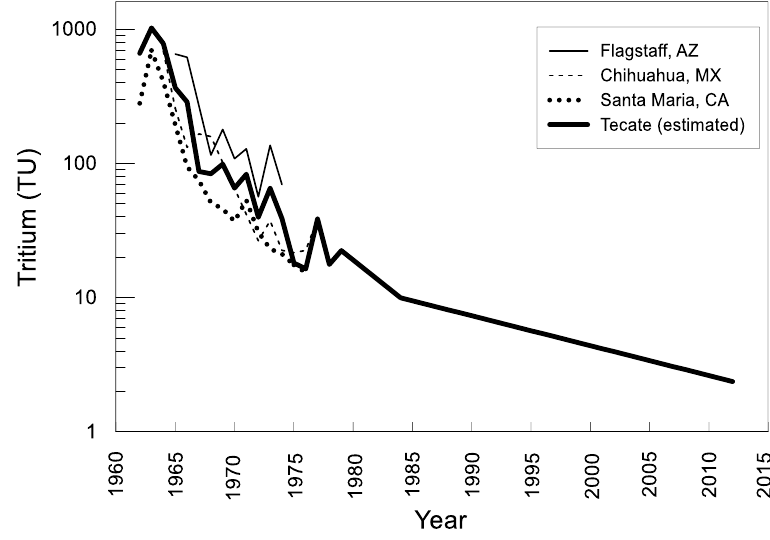
Figure 9. Estimated input function of tritium using the IAEA-GNIP network data of the three closest stations Santa María (California), Flagstaff (Arizona), and Chihuahua (Mexico).